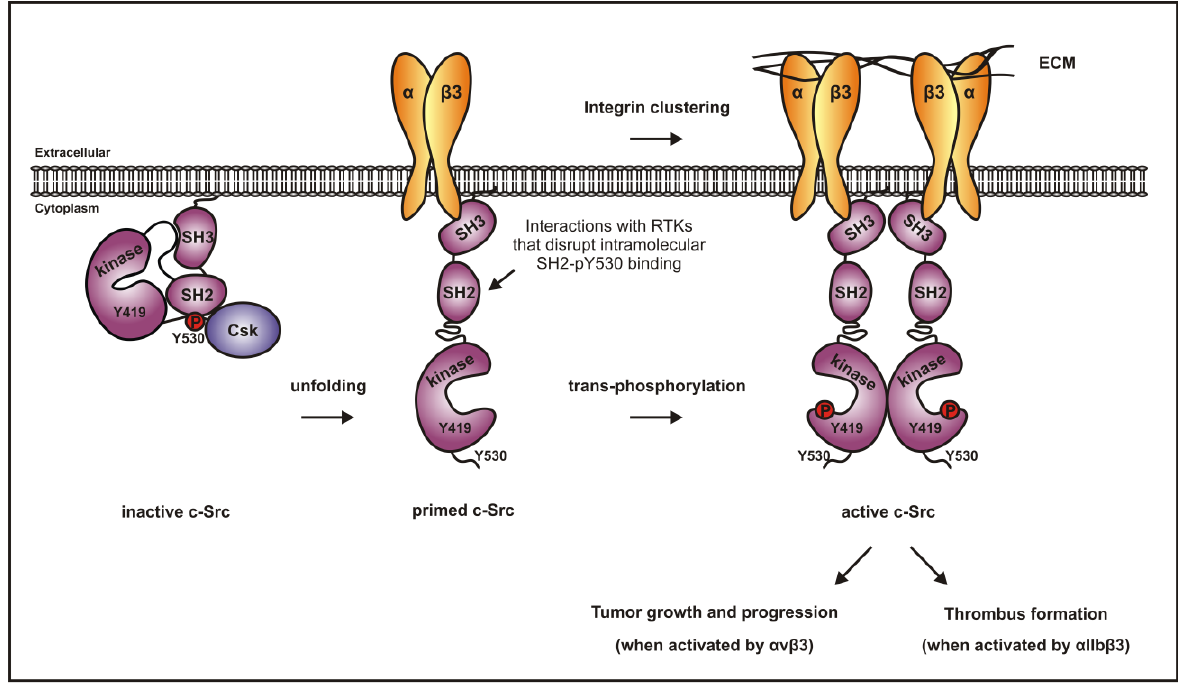
FIGURE 1 . Model of c-Src activation by β3